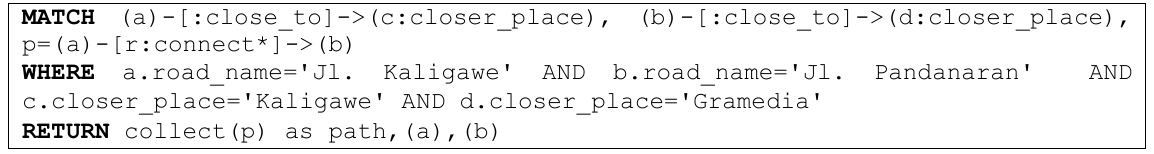
Fig. 9. Example of cypher query to search multimodal